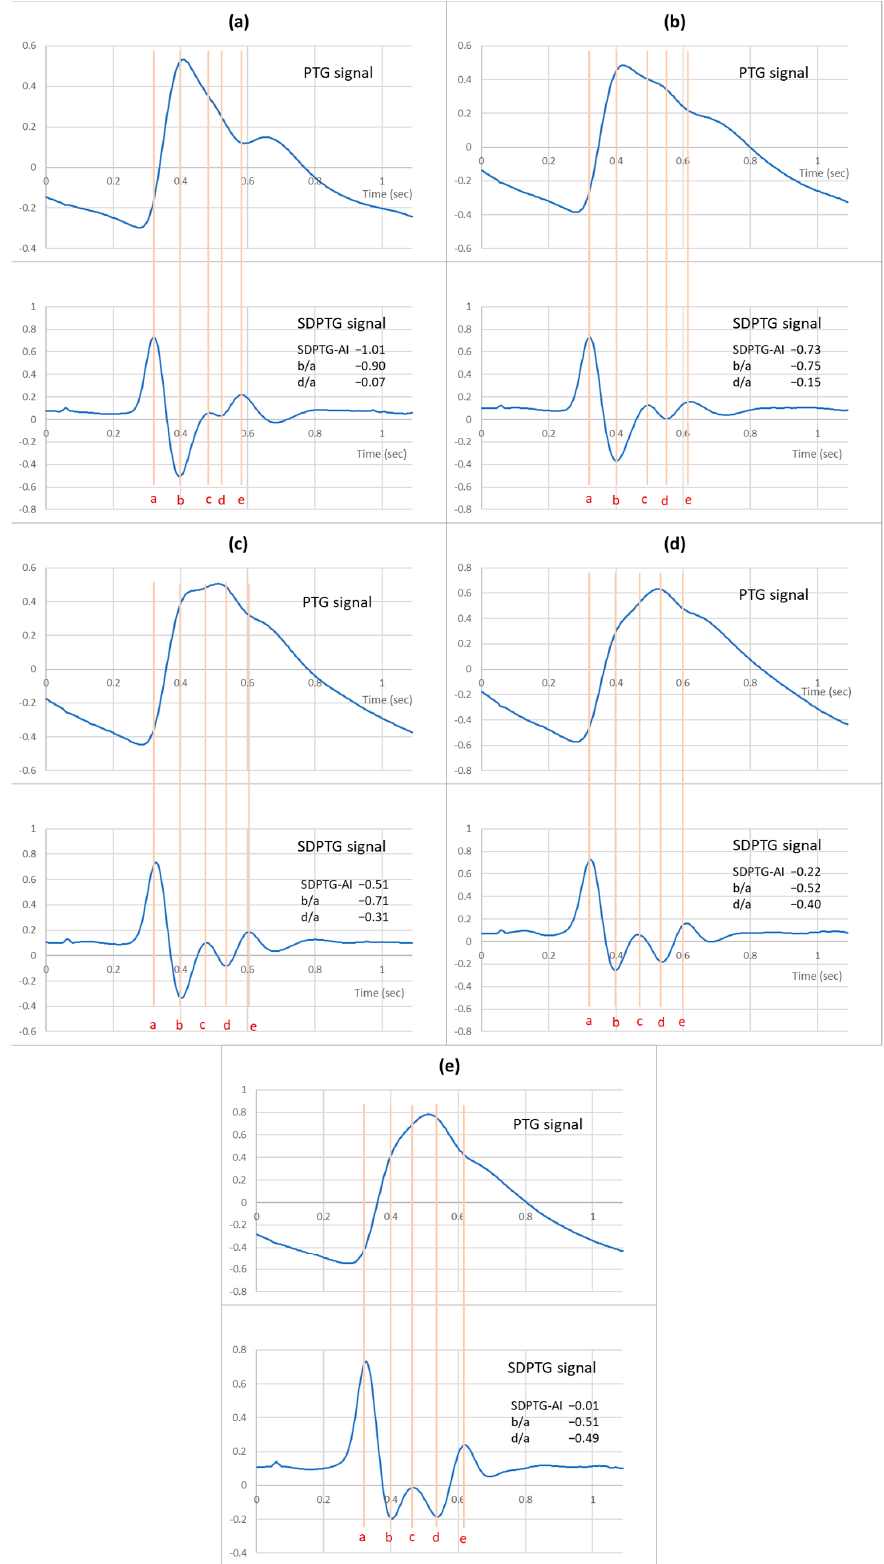
Figure 2. Photoplethysmogram (PTG) and second derivative PTG (SDPTG) measured for five participants aged in their 20 s ( a ), 30 s ( b ), 40 s ( c ), 50 s ( d ) and 60 s ( e ).